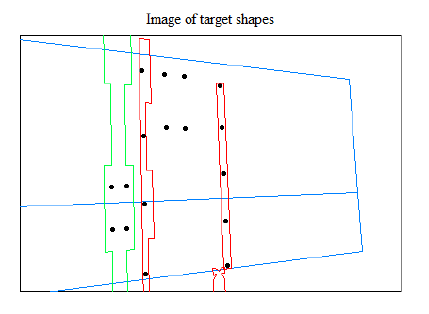
Figure 3 Simulation of refracted images